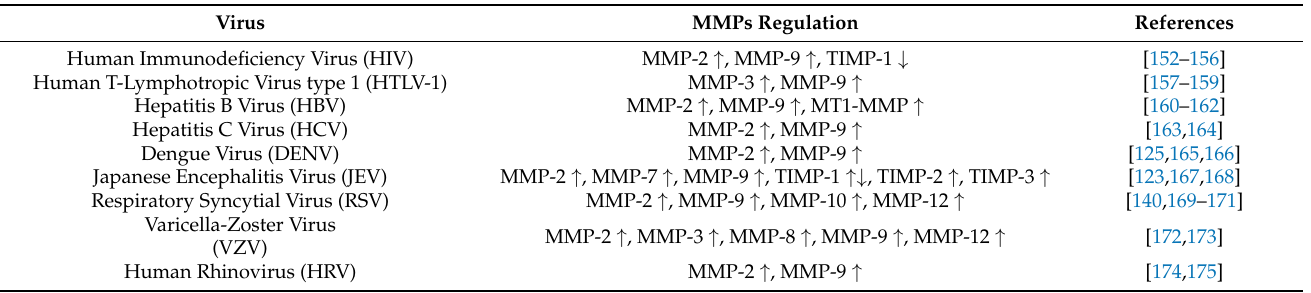
Table 1. Viral infections in which matrix metalloproteinases activity is associated with pathology.